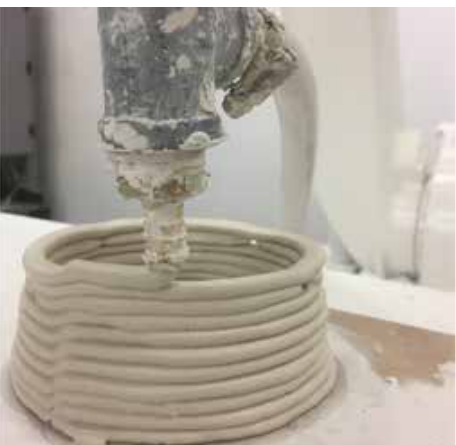
Figure 11: Iterative testing of the additive manufacturing process, using the end effector installed on the robot’s